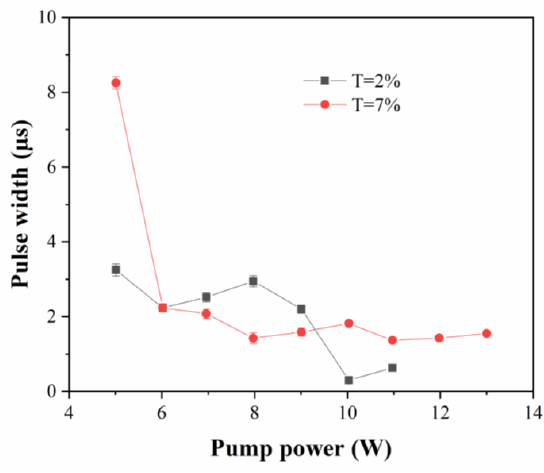
Figure 4. Pulse widths of Tm,Ho:LuVO 4 laser verse the pump power.